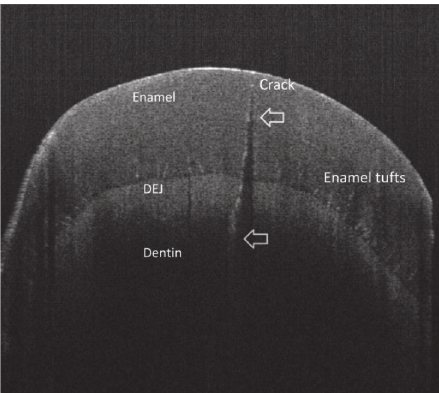
Figure 4: SS-OCT image of the dentin crack. The crack extended beyond the DEJ and displayed as a bright white line